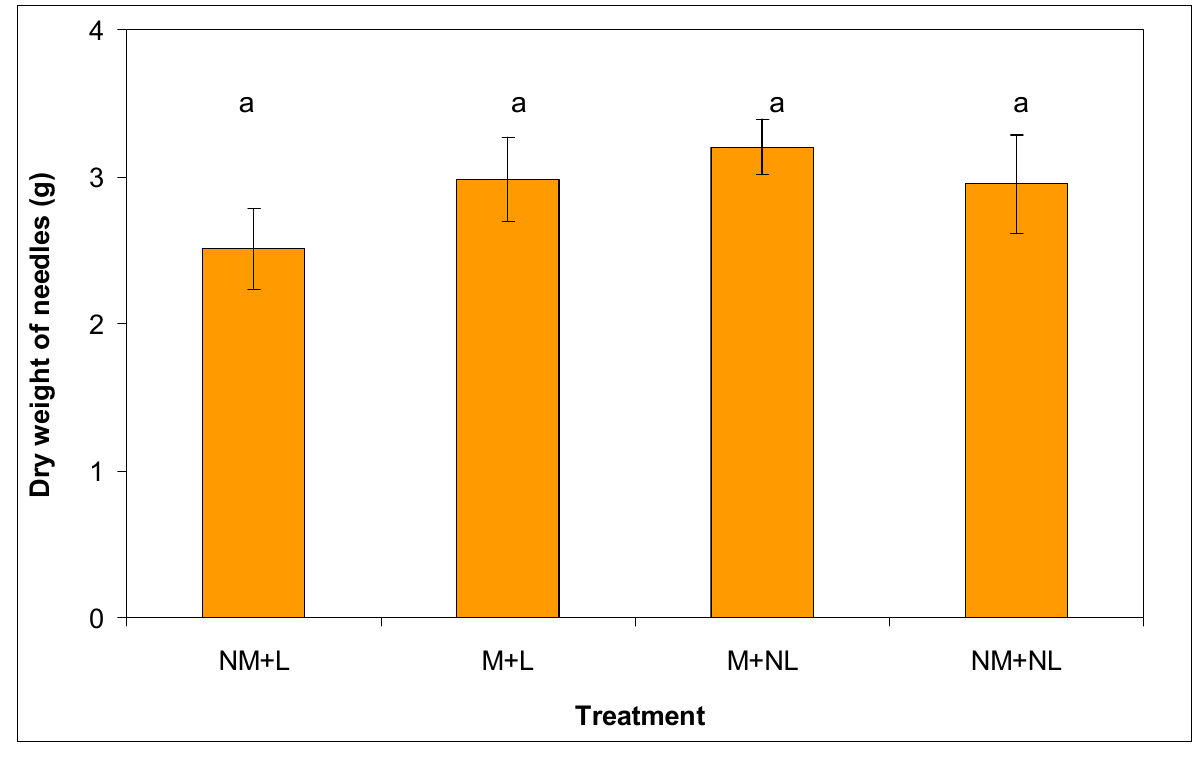
Figure 4. Morphometric characteristics of seedlings (mean ± standard deviation) of Pinus halepensis Mill. growing in plots subjected to four treatments in Sierra de Los Donceles forest (Liétor, Castilla La Mancha, Spain). Length of aerial part ( a ), length of roots ( b ), dry weight of aerial part ( c ), dry weight of roots ( d ), dry weight of needles ( e ). Different letters indicate significant differences among treatments according to the LSD test ( p < 0.05). Legend: M + L = Mulching + Logging; NM + L = No Mulching + Logging; NM + NL = No Mulching + No Logging; M + NL = Mulching + No Logging.